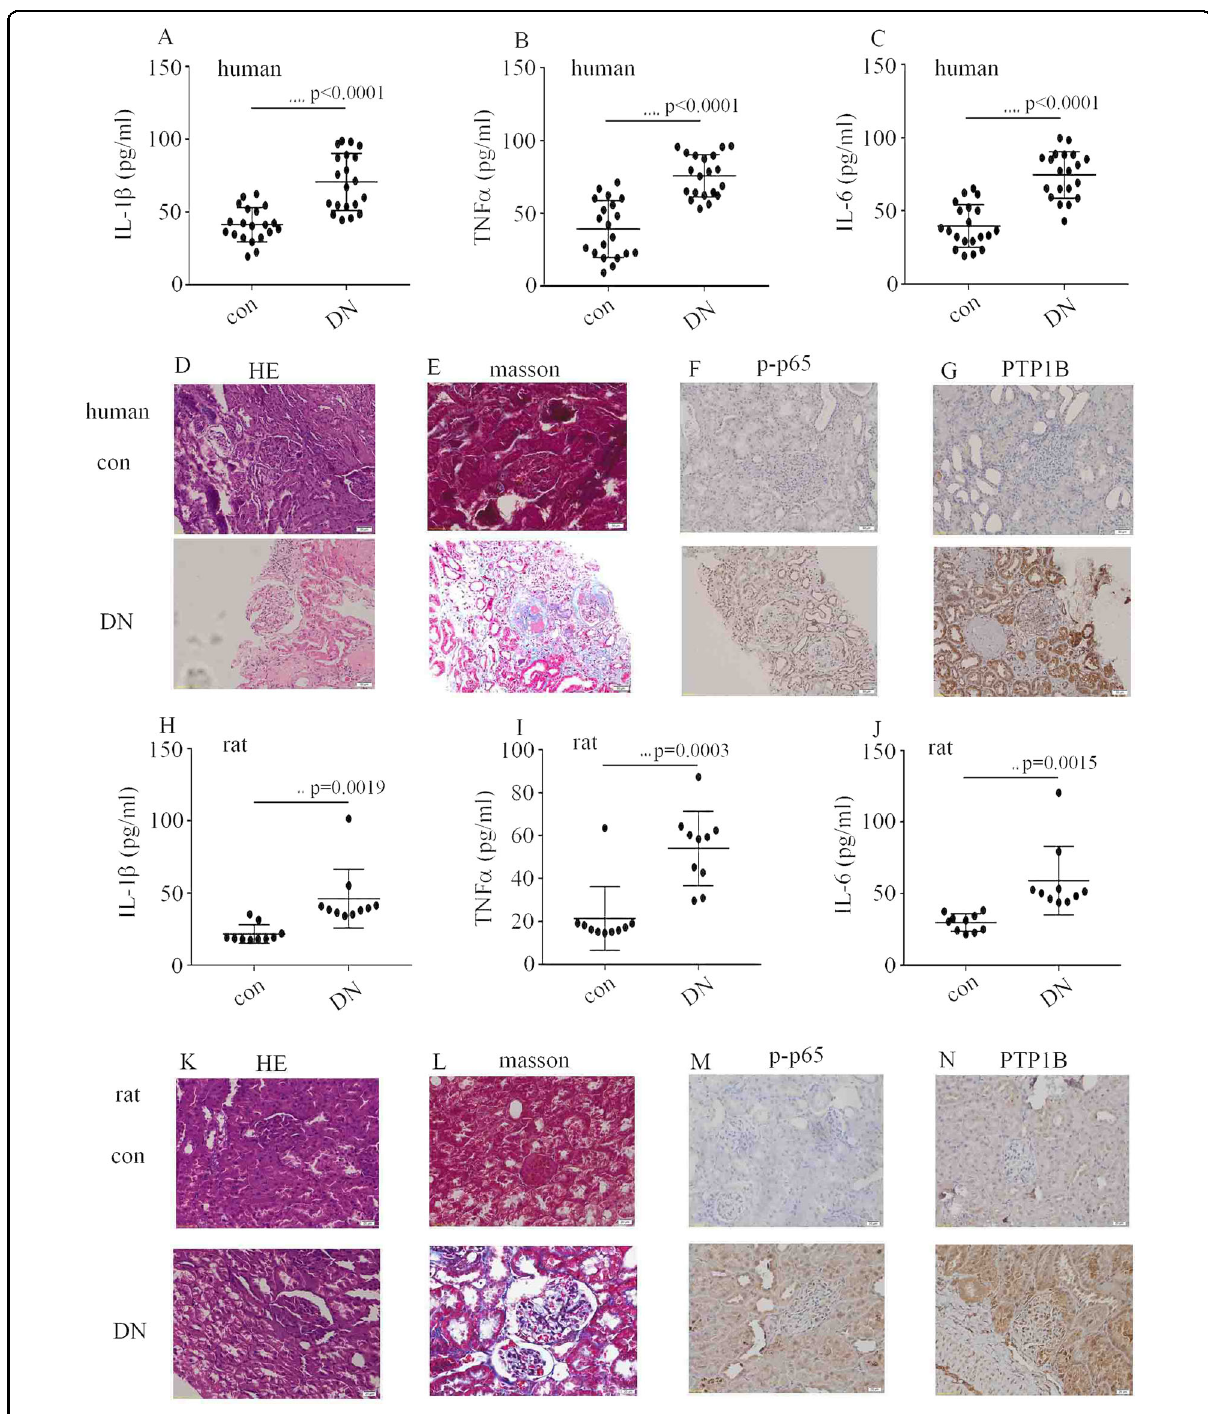
Fig. 1 Augmentation of plasma in fl ammatory factor levels and increased glomerular PTP1B expression in DN patients and rats. A – C ELISA indicated that IL-1 β , TNF α and IL-6 were increased in DN patients ( n = 20/group). D Haematoxylin – eosin staining (HE) of renal biopsy specimens from DN patients and control participants. E Masson staining of renal biopsy specimens from DN patients and control participants. F Immunohistochemistry (IHC) of p-p65 in renal biopsy specimens of DN patients and control participants. G IHC of PTP1B in renal biopsy specimens of DN patients and control participants. H – J ELISA indicated that IL-1 β , TNF α and IL-6 were increased in DN rats ( n = 10/group). K HE of renal biopsy specimens of DN rats and control rats. L Masson staining of renal biopsy specimens of DN rats and control rats. M IHC of p-p65 in renal biopsy specimens of DN rats and control rats. N IHC of PTP1B in renal biopsy specimens of DN rats and control rats. (* p < 0.05, ** p < 0.01, *** p < 0.001, **** p < 0.0001, n =